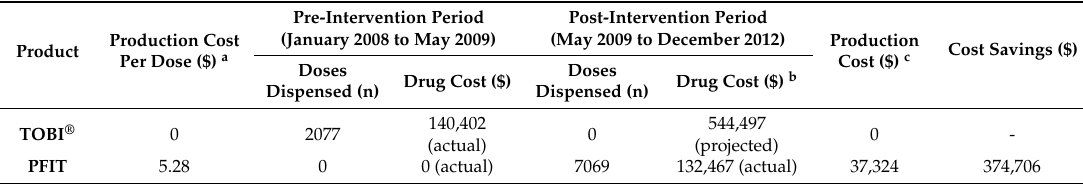
Table 3. Comparison of the inhaled tobramycin automatic therapeutic substitution intervention, price-adjusted to 2013 US